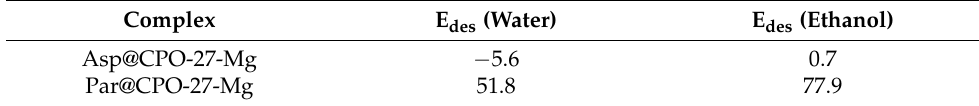
Table 2. Energies of molecules desorption to a solvent,